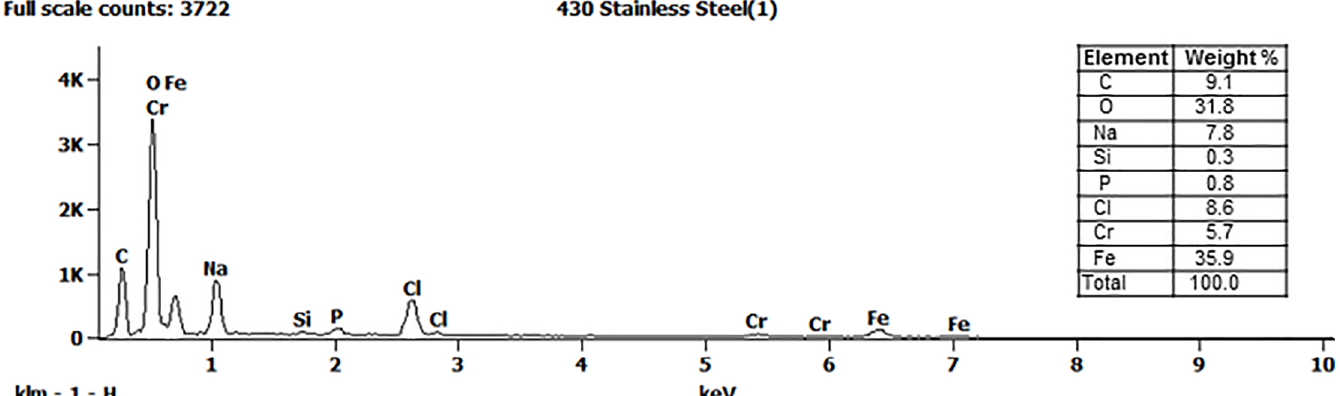
Fig 4. Energy dispersive X-ray spectroscopy: elements in the residue on an AISI Type 430 carrierafter efficacytesting with the QCT-2 method.